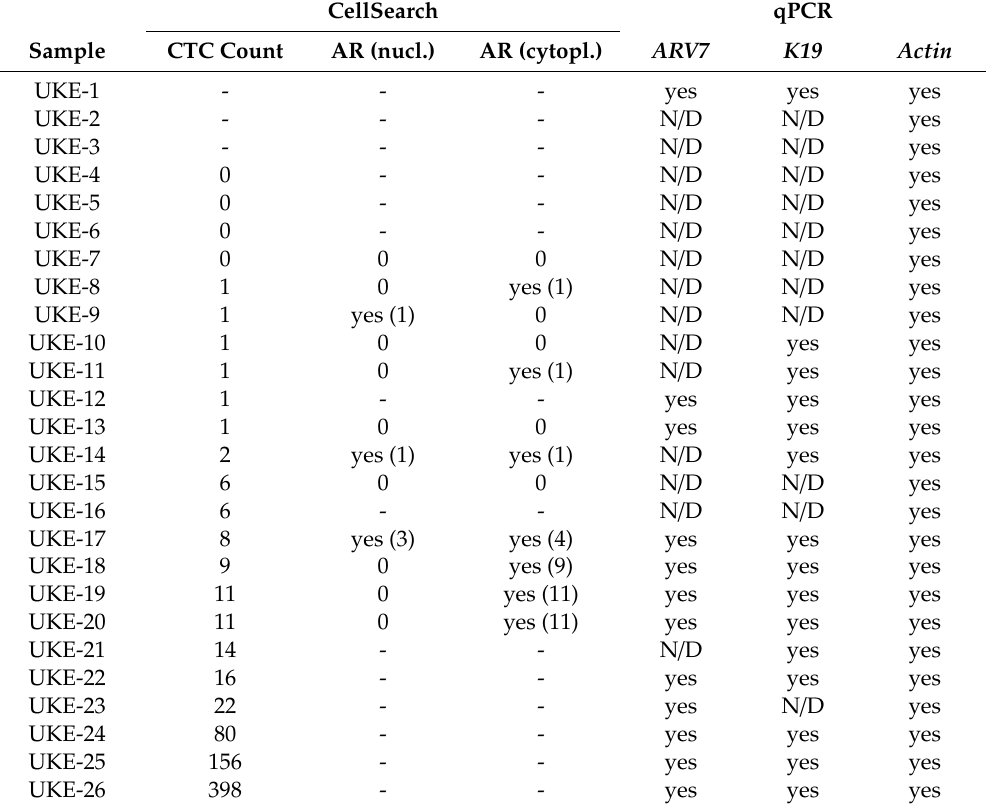
Table 4. Correlation of qPCR results, AR-FL detection and CTC enumeration via CellSearch for 26 mPCa patients analyzed. Detection of a gene was confirmed when at least 2 / 3 triplicates were positive in qPCR analysis. N / D signifies no gene expression or gene expression above the set threshold of 35 cycles. CTC enumeration via CellSearch ® was not conducted for the first three patient samples, indicated by a bar in the respective table column (-). This also applies to 14 samples collected regarding AR occurrence. The number of CTCs with detectable AR-FL expression is indicated in